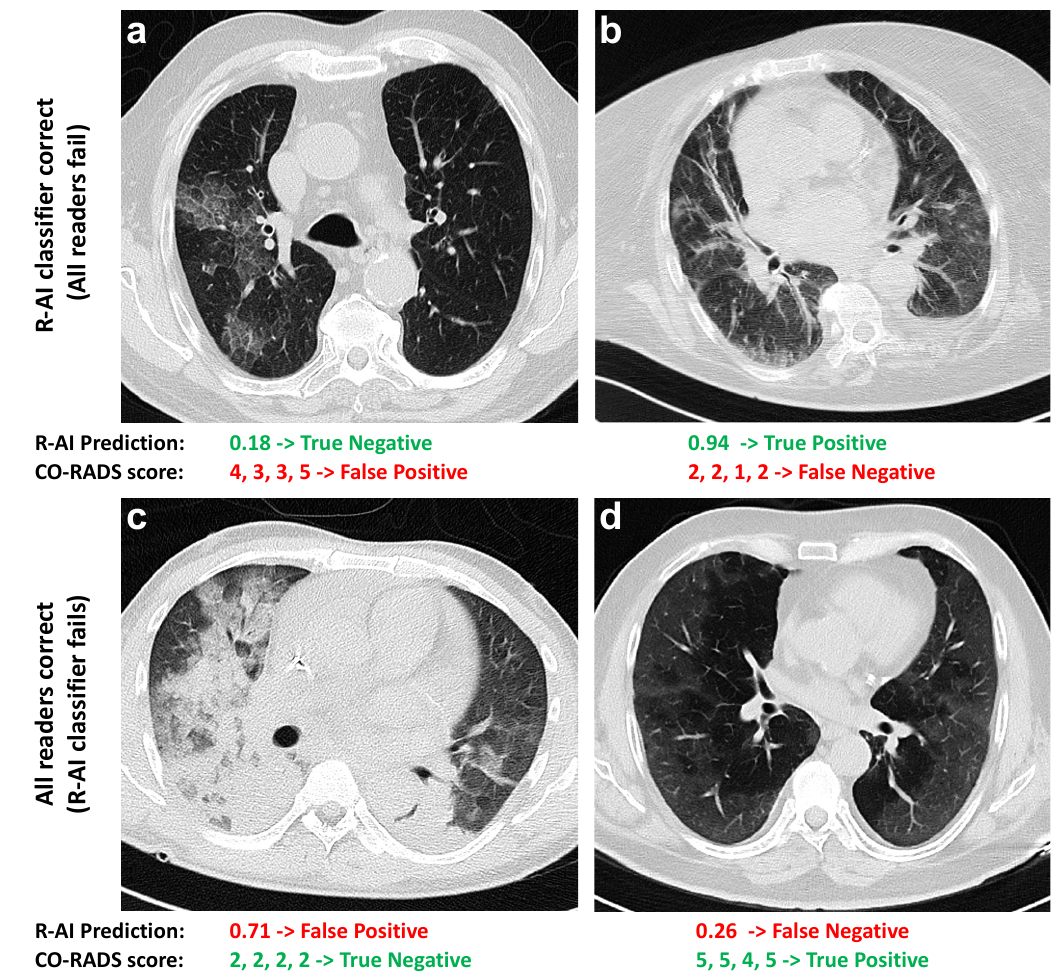
Figure 1. Exemplary cases of different situations occurred in the classification task. For each case, the probability output of the R-AI classifier and the CO-RADS scores assigned by the readers are reported. Final diagnoses by molecular testing were: ( a ) parainfluenza virus 4 pneumonia; ( b ) COVID-19 pneumonia; ( c ) rhinovirus pneumonia; ( d ) COVID-19 pneumonia.